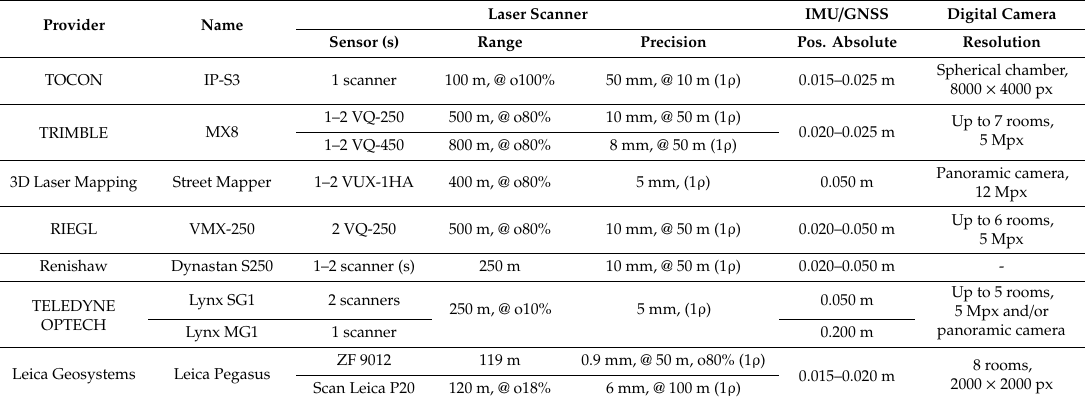
Table 6. The most common commercial mobile mapping systems and related components post-processed accuracy values given as